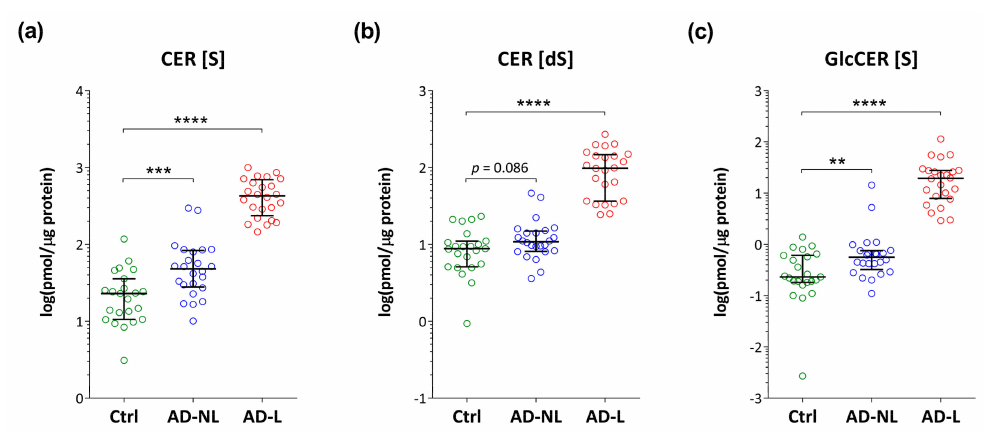
Figure 3. Levels of free sphingoid bases’ ( a ) sphingosine (S) and ( b ) sphinganine (dS), and ( c ) their ratio R [dS] / [S] in the skin of healthy controls (Ctrl) and non-lesional (AD-NL) and lesional (AD-L) skin in AD patients. Data are shown as median with interquartile ranges. **** p < 0.0001, *** p < 0.001, * p < 0.05. As compared to healthy skin, the levels of all investigated ceramides and glucosylceramide were higher in both non-lesional and lesional skin of AD patients (Figure 4), with exception of sphinganine ceramide, CER (dS), which reached a border-line significance ( p = 0.09).